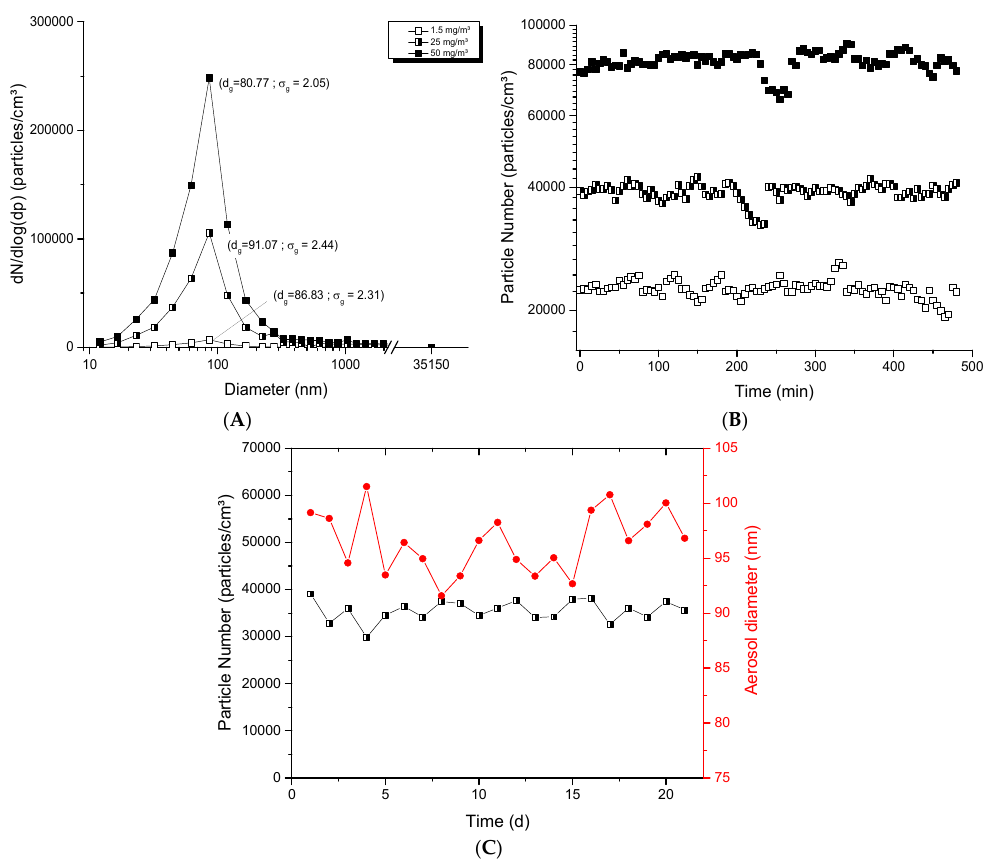
Figure 3. Evaluation of aerosols generated with the dust jet generator: ( A ) size distribution of typical TiO 2 aerosols as function of mass concentration; ( B ) stability of aerosols during 8 h; ( C ) long ‐ term stability of the number of particles and diameter in the aerosols over 21 days. The TiO 2 (20 nm) nanopowders were used with an airflow rate of 0.7, 1 and 4.5 L/min in ( A ); 0.8, 0.9 and 1.25 L/min in ( B ); 0.9 L/min in ( C ) to generate an aerosol per day during 21 days. The red points represent diameters of particles in the aerosol (nm) monitored at specific time points over 21 days (see right ordinal axis).